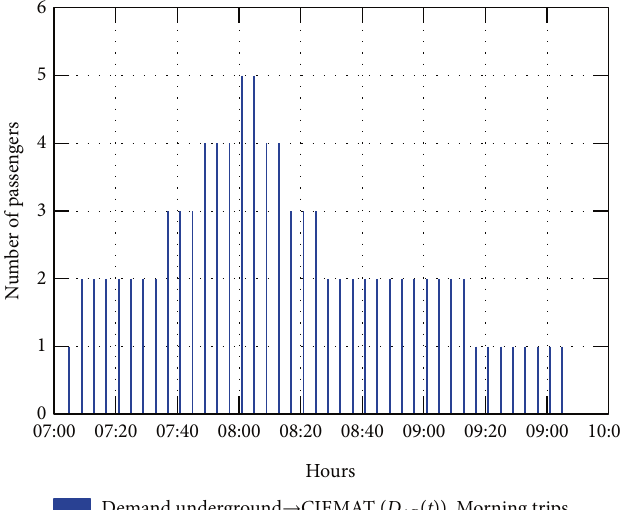
Figure 8: Temporal distribution of CIEMAT sta ff members ’ arrivals per time slot during the morning